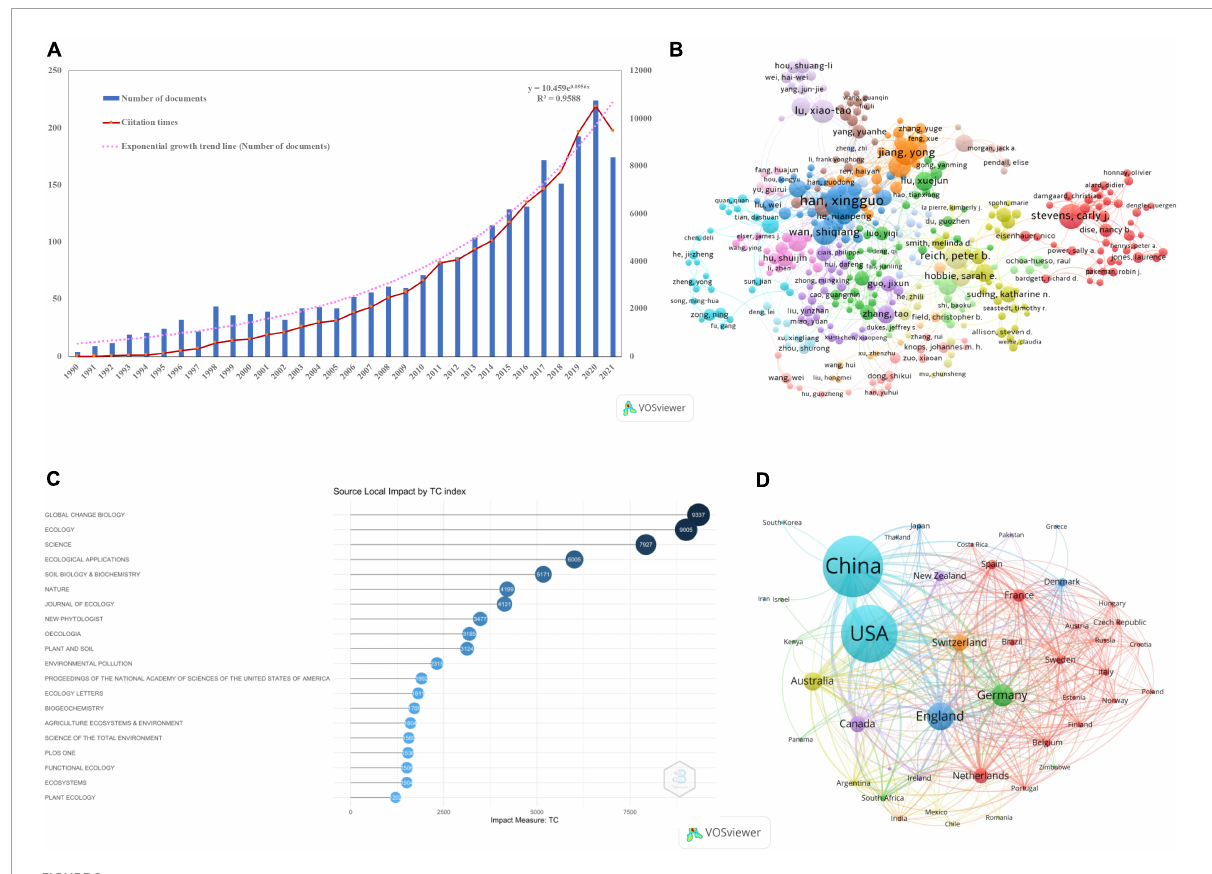
FIGURE2 Temporal trend and change point of all papers and cumulative papers in terms of annual publications (A) ; the network visualization map of 598 authors out of 8,173 authors with more than five publications as produced by VOSviewer (B) ; top 20 journals based on total local citations as produced by R (C) ; the network visualization map of 43 countries out of 89 countries with more than five publications as produced by VOSviewer (D)